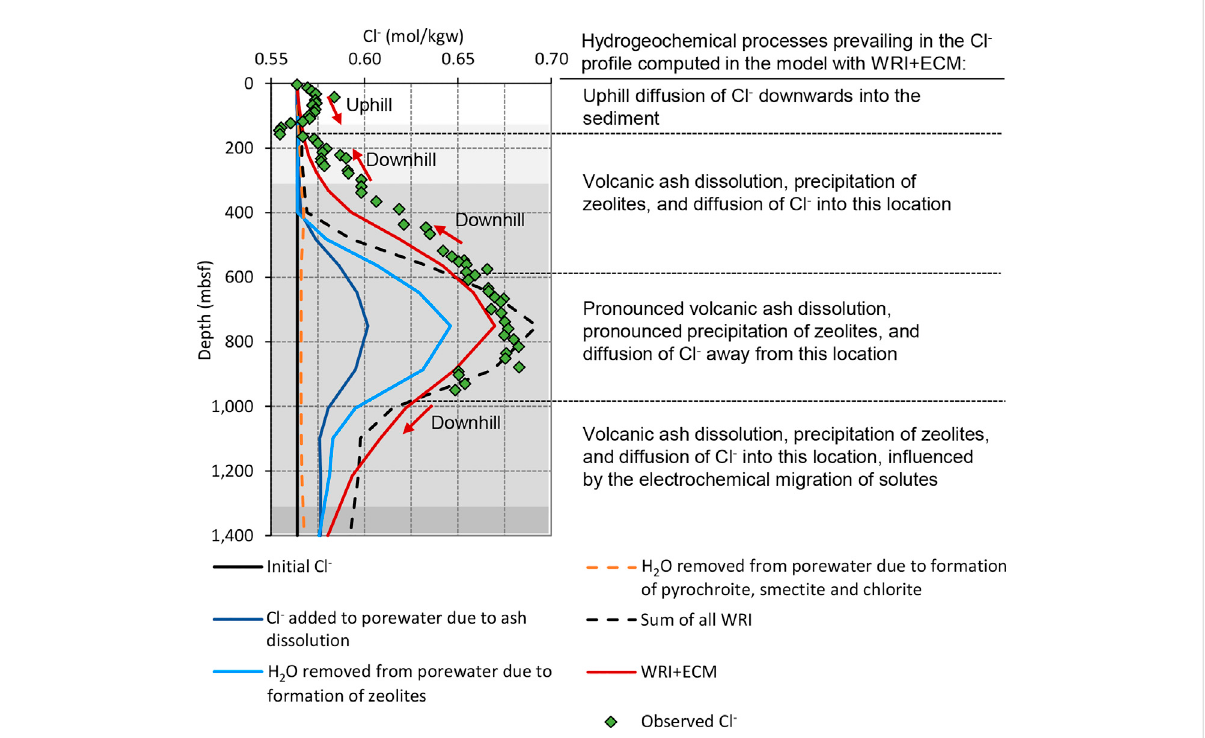
FIGURE 10 Identi fi cation of the hydrogeochemical processes prevailing in the different parts of the chloride pro fi le computed in the reaction-diffusion model that couples water-rock interactions to electrochemical migration of solutes (WRI+ECM). The graded grey background indicates the four lithological units shown in Figure